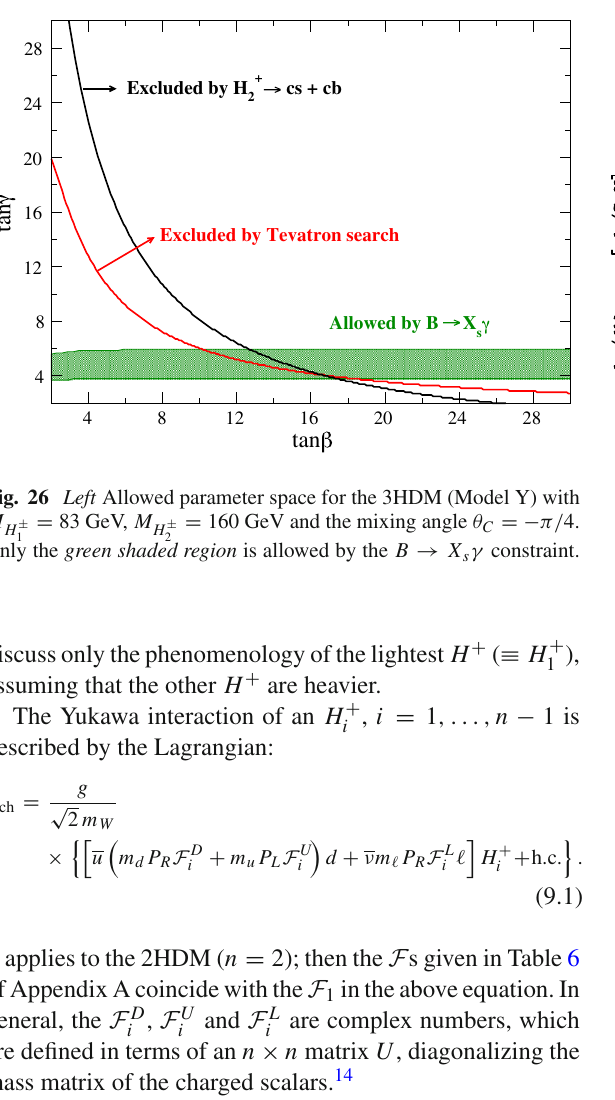
Right Di-jet invariant mass distributions for signal ( red ) and back- = − π/ 4. ground ( black ) for a particular benchmark point (3HDM, Model Y) C at the 13 TeV